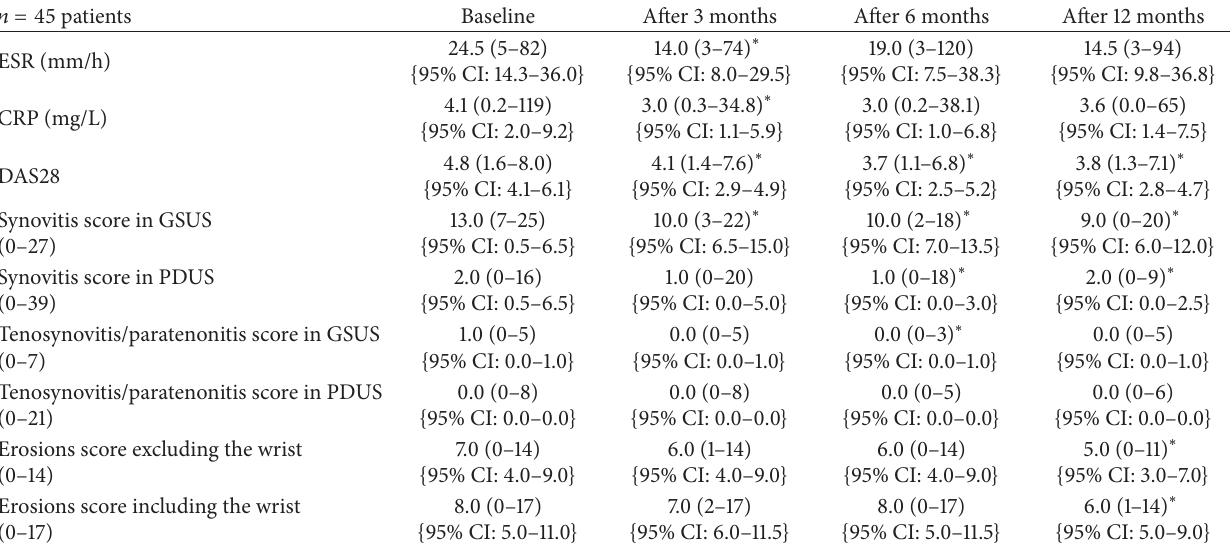
Table 1: Laboratory, clinical, and US7 score data over one year.